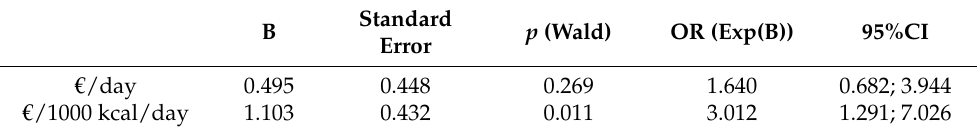
Table 3. Association of monetary cost of diet and adherence to the Mediterranean diet. B Standard Error p ( Wald) OR (Exp(B)) 95%CI €/day 0.495